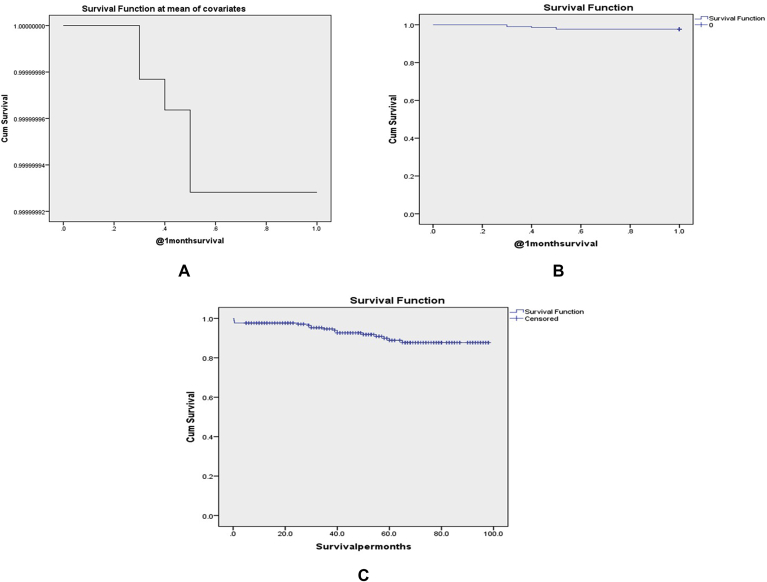
(A) Cox Regression 1-month survival curve(B) Kaplan-Meier 1-month survival curve(C) Kaplan-Meier overall survival curve.